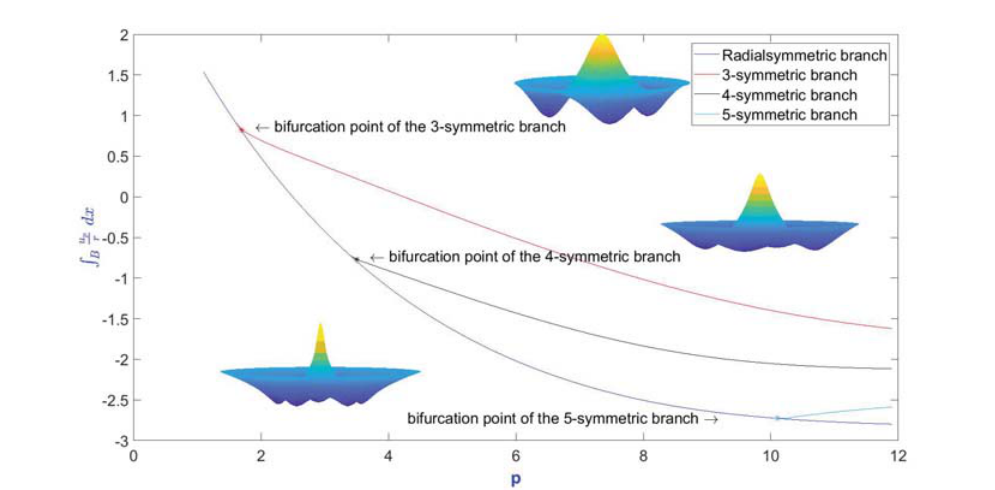
Fig. 7: Bifurcation diagram of the numerical solutions with two nodal